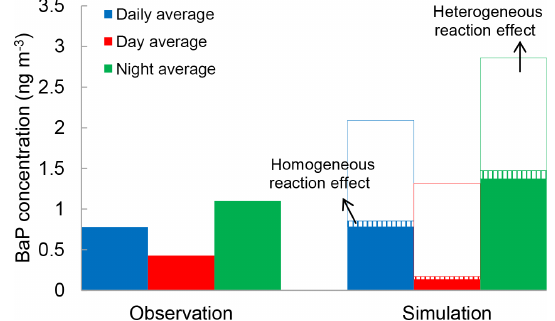
Figure 8. Simulated concentrations of BaP compared with observa- tion at the Xianghe site during 11–22 July 2013. The contributions of heterogeneous and homogeneous reaction are shown are shown as blank areas and as small vertical bars, respectively, in the simu- lation